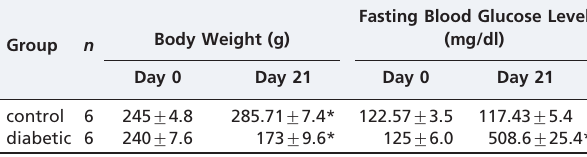
Table 1 - Fasting blood glucose level (mg/dl) and body weight (g) before and after the induction of